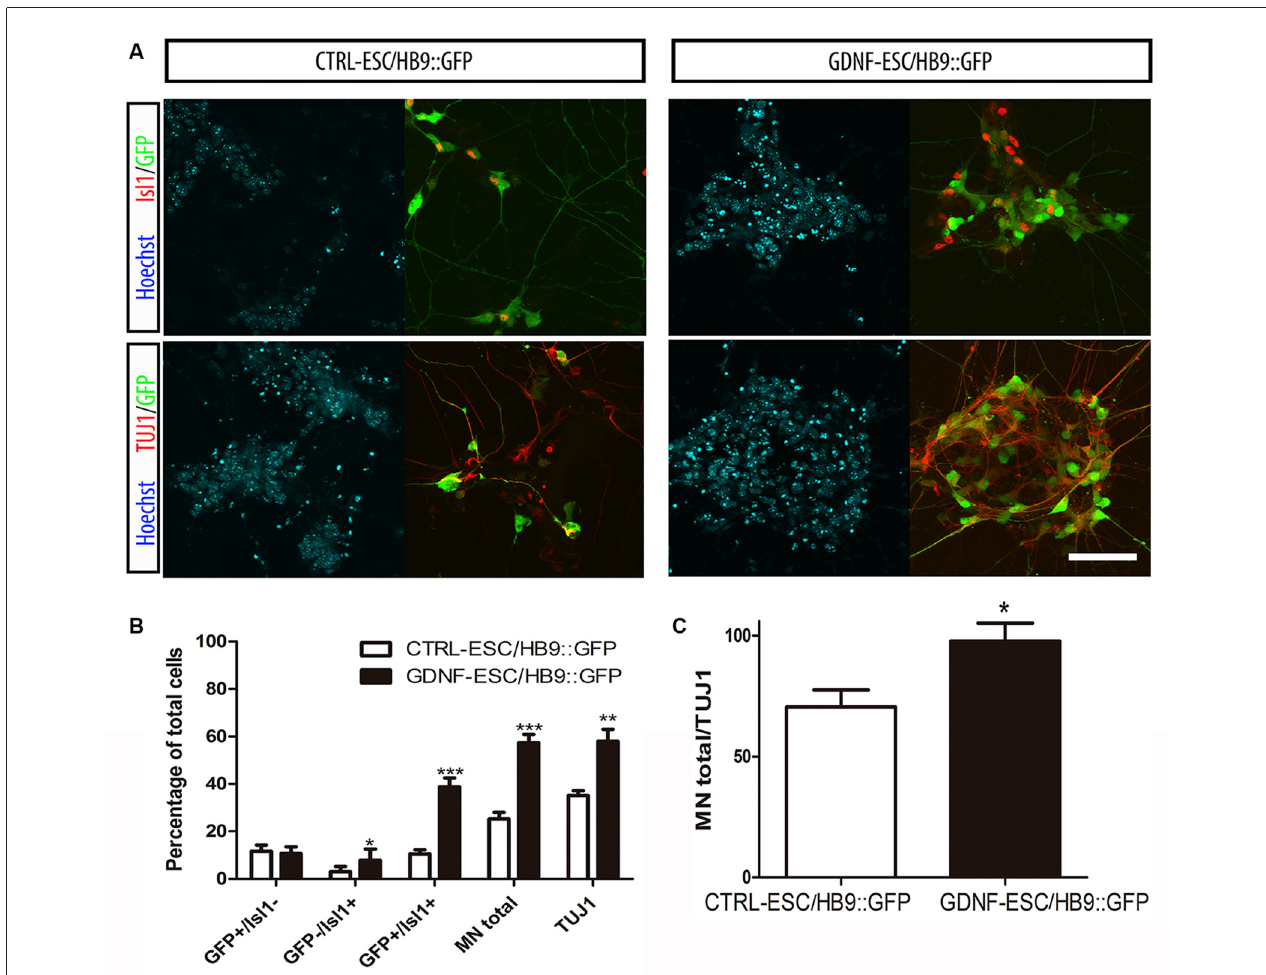
FIGURE 3 | Transgenic GDNF expression increases the yield of postmitotic MN. (A) Immunostaining of postmitotic neurons at day 7 of differentiation. (B) Percentage of MNs (i.e., GFP+ or Isl1+) relative to the number of total neurons. (C) Percentage of MNs (i.e., GFP+ or Isl1+) relative to the number of total neurons. Scale bar: 50 µ m except for Figure 4C where scale represents 47 µ m. ∗ p < 0.05, ∗∗ p < 0.001 and ∗∗∗ p < 0.0001 vs. CTRL-ESC/HB9::GFP. Data from four experiments in